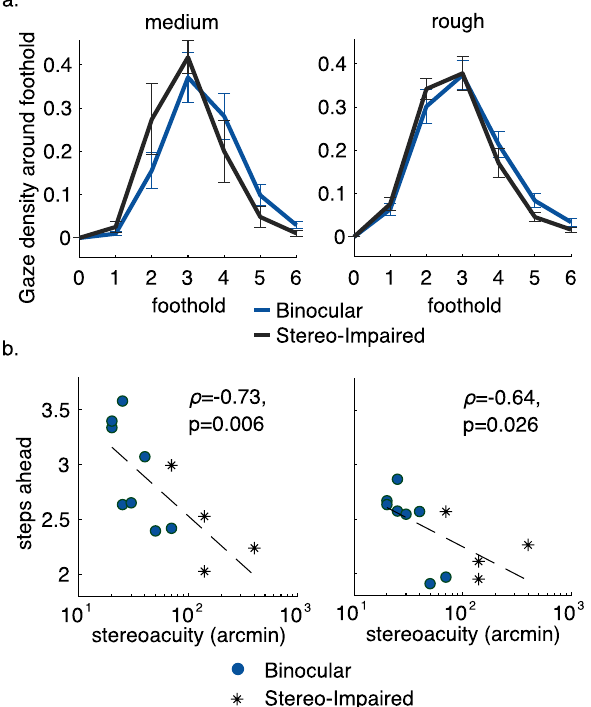
Figure 4. Examining the original 8 participants as well as an additional 4 participants with impairment to binocular function due to visual disorders reveals a relationship between the bias of gaze toward the body and stereoacuity. ( a ) Gaze density around footholds as in Fig. 3b, showing the binocular condition from the original participants and stereo-impaired participants, for medium and rough terrains. Error bars are ± 1 SEM between participants. The dark blue curve shows the binocular conditions from Fig. 3b, and the light blue curve shows data for the 4 stereo-impaired participants. ( b ) Average footholds ahead as a function of participant stereoacuity. Average footholds ahead (y-axis) is calculated by taking the vector average of the gaze density around the foothold plotted in a (above). Stereo-acuity (x-axis) is measured as described in the Methods using the Randot metric. Correlation for the linear regression fits are shown in the Figure, with associated significance values.